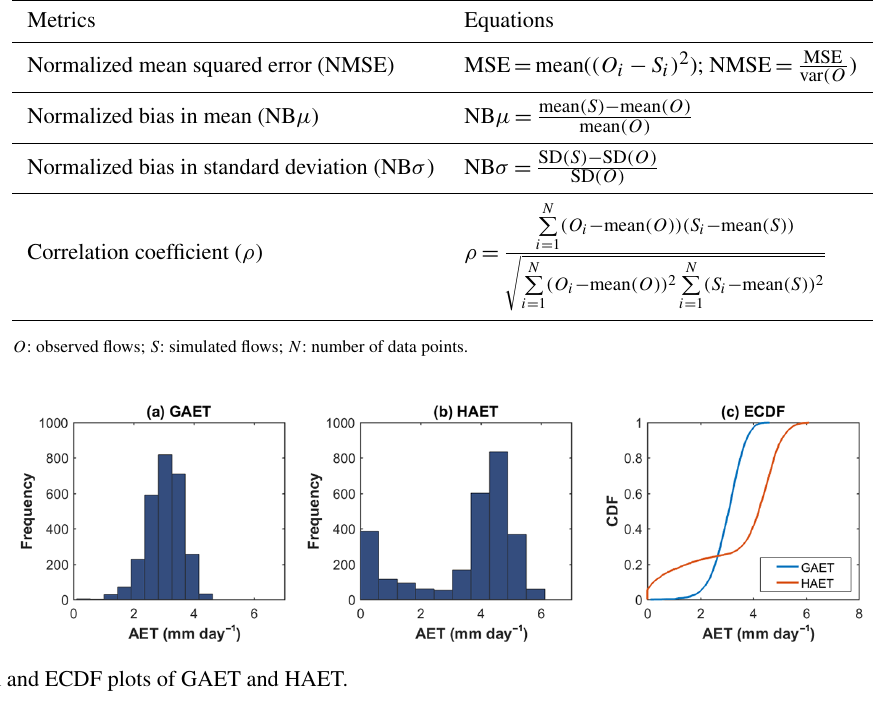
Table 2. Performance evaluation metrics used in this study.